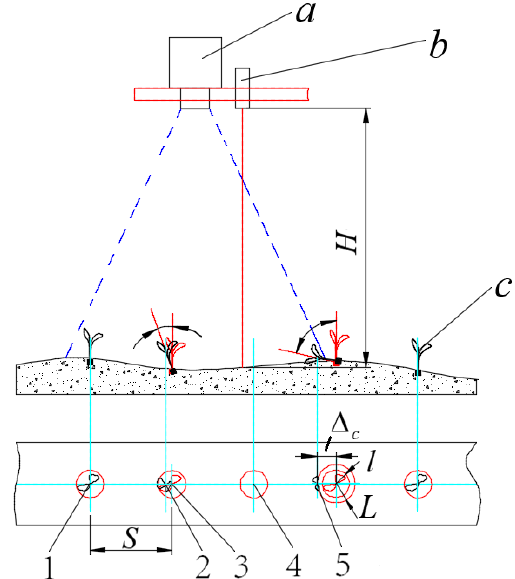
Figure 5. Schematic diagram of cavitation and lodging state. ( a ) Industrial camera and lens, ( b ) Ranging sensor, ( c ) Rape seedling, (1) Qualified status, (2) Actual planting position, (3) Theoretical planting position, (4) Cavitation, (5) Lodging.